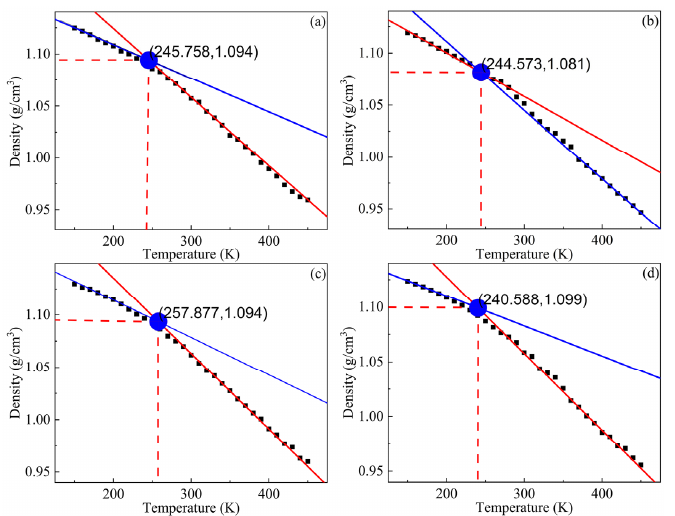
Figure 4. The glass transition temperatures of HTPE binder systems. ( a ) S-1, ( b ) S-2, ( c ) S-3 and ( d ) S-4